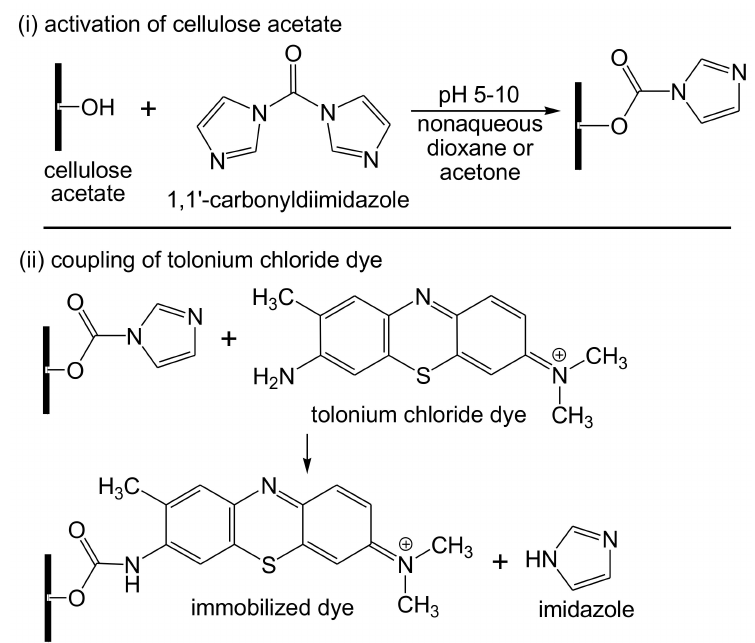
Figure 13. Immobilization of tolonium chloride (toluidine blue O) dye onto cellulose